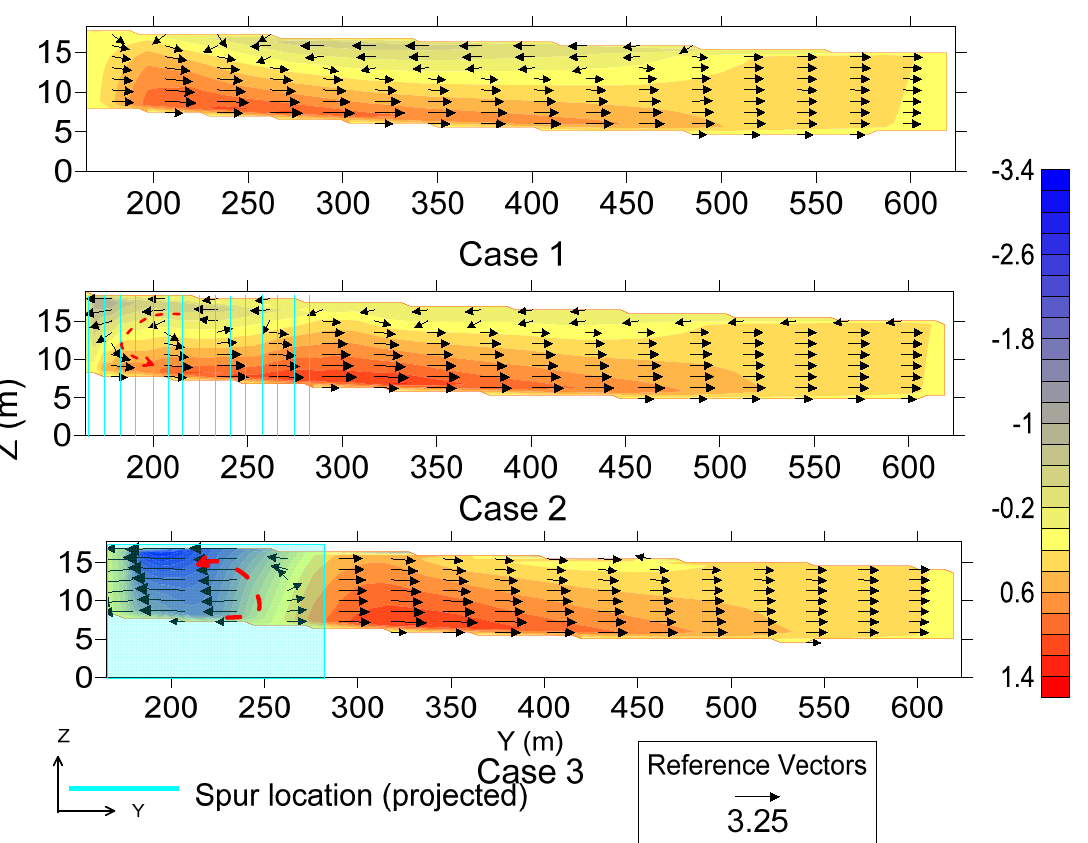
Figure 17. The distribution of the transverse velocity ( 𝑣, 𝑤 ) in m/s. The contours show the variation in the transverse velocity 𝑣 in m/s.